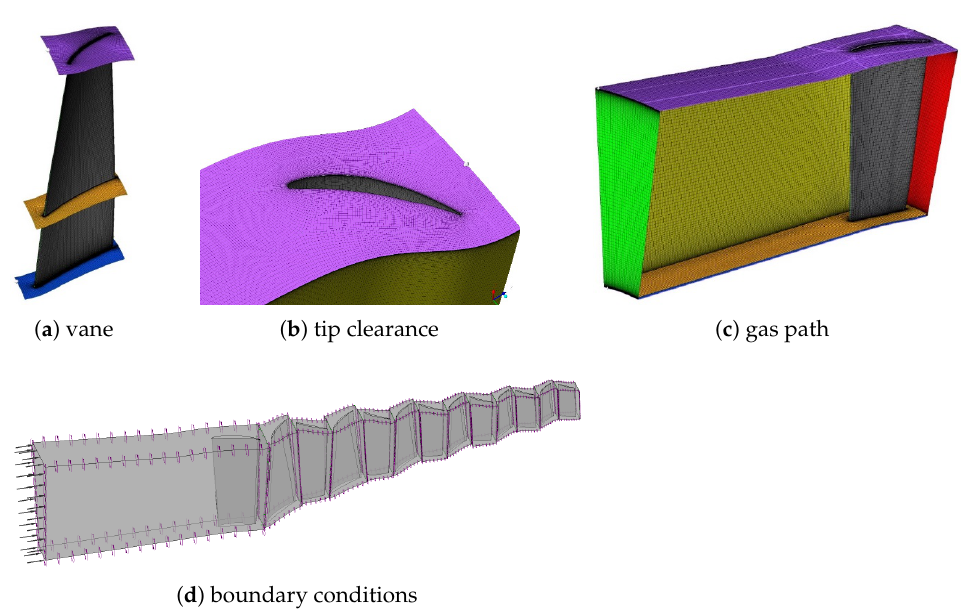
Figure 5. Airflow model of the